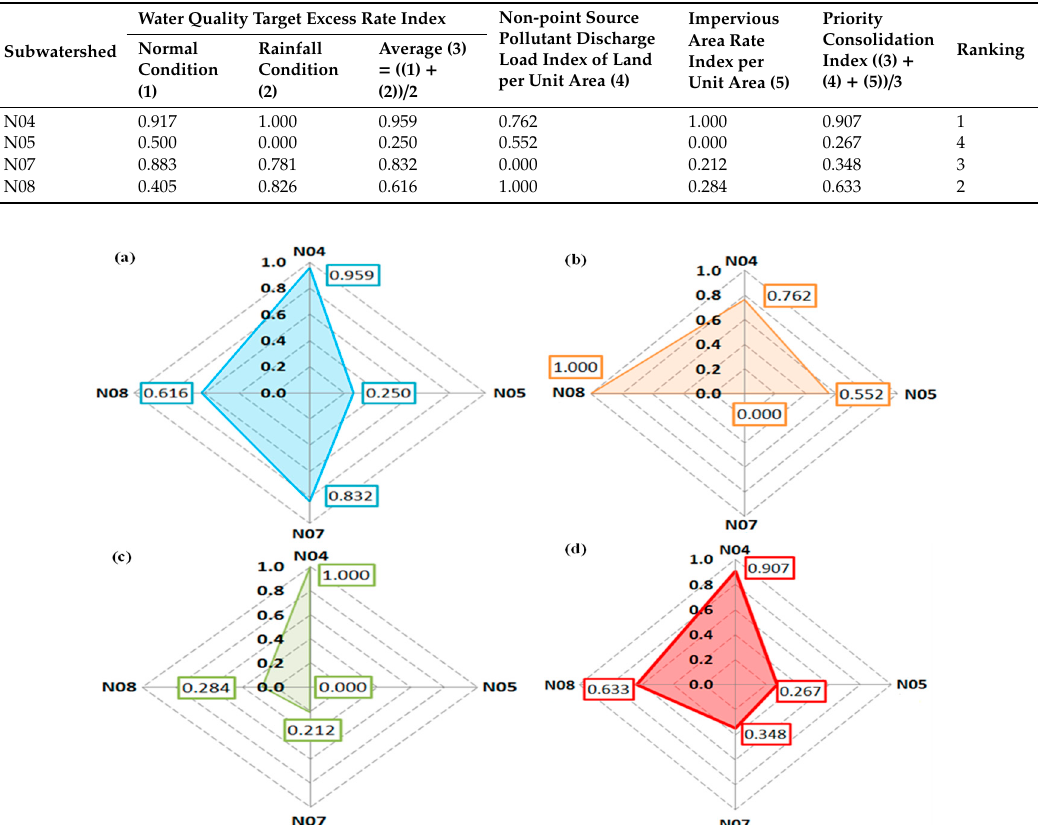
Figure 8. Priority index analysis diagram for each sub-watershed (( a ): water quality target excess rate index, ( b ): non-point source pollutant discharge load index of land, ( c ): impervious area index, ( d